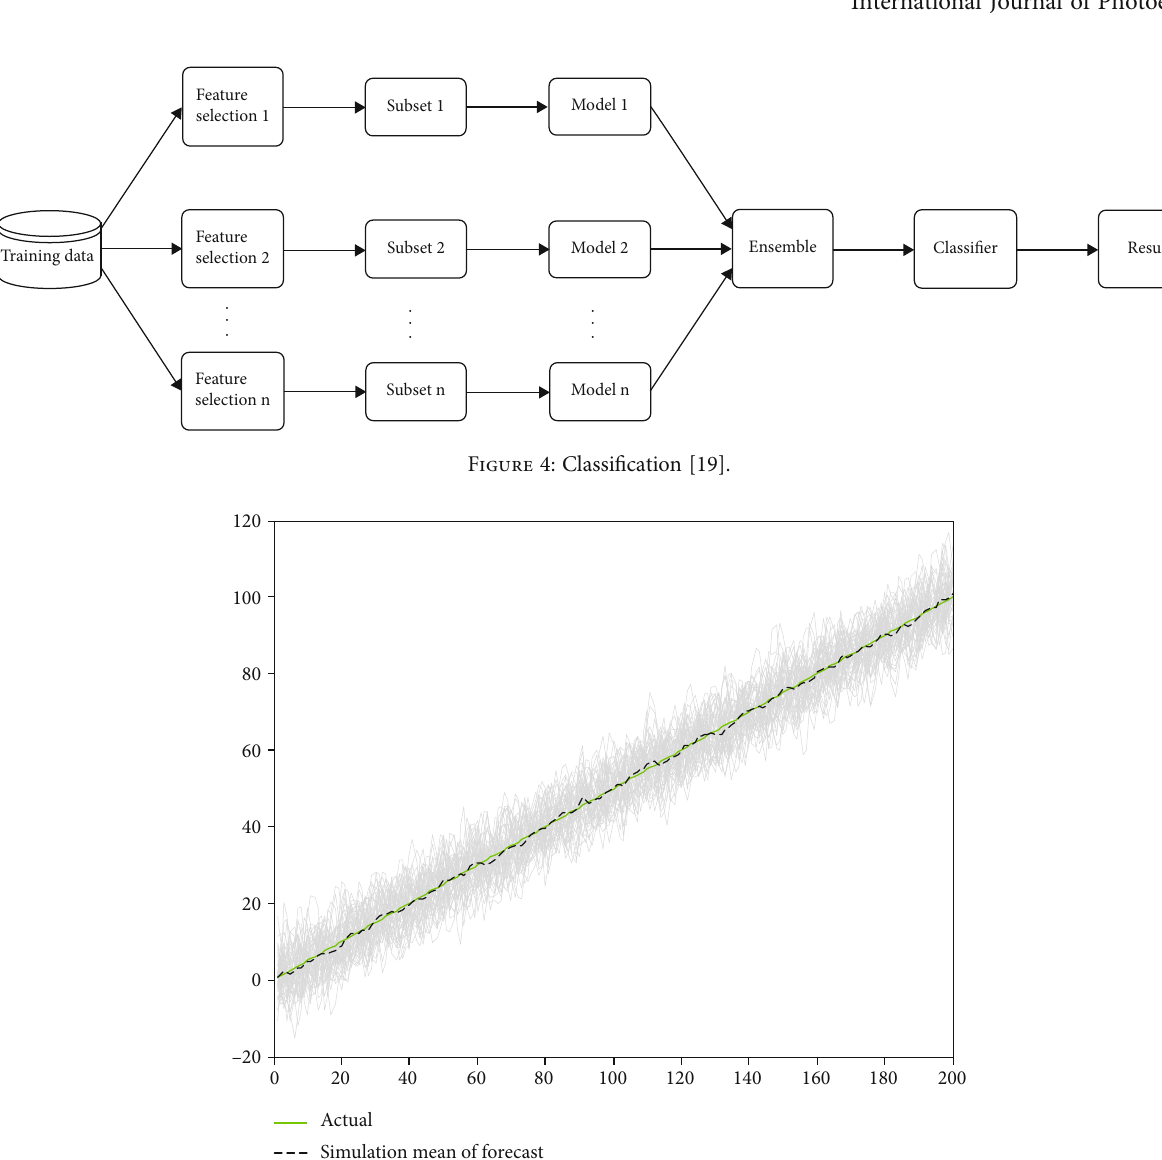
Figure 5: Observations from ensemble model for smaller PV